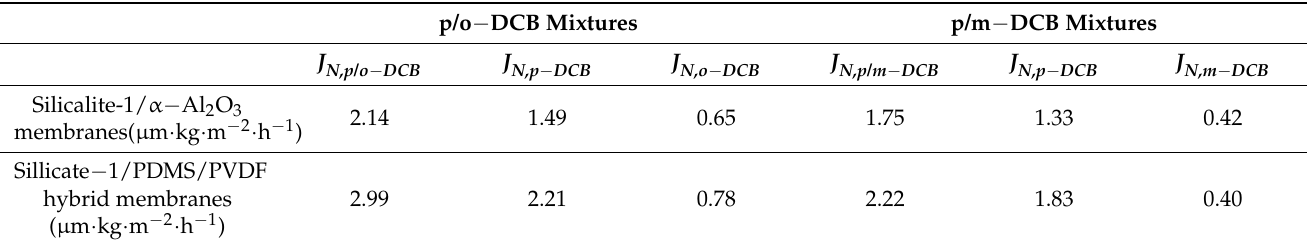
Table 2. Thickness − normalized pervaporation fluxes for silicalite-1/ α − Al 2 O 3 membranes and the sillicate − 1/PDMS/PVDF hybrid membranes.